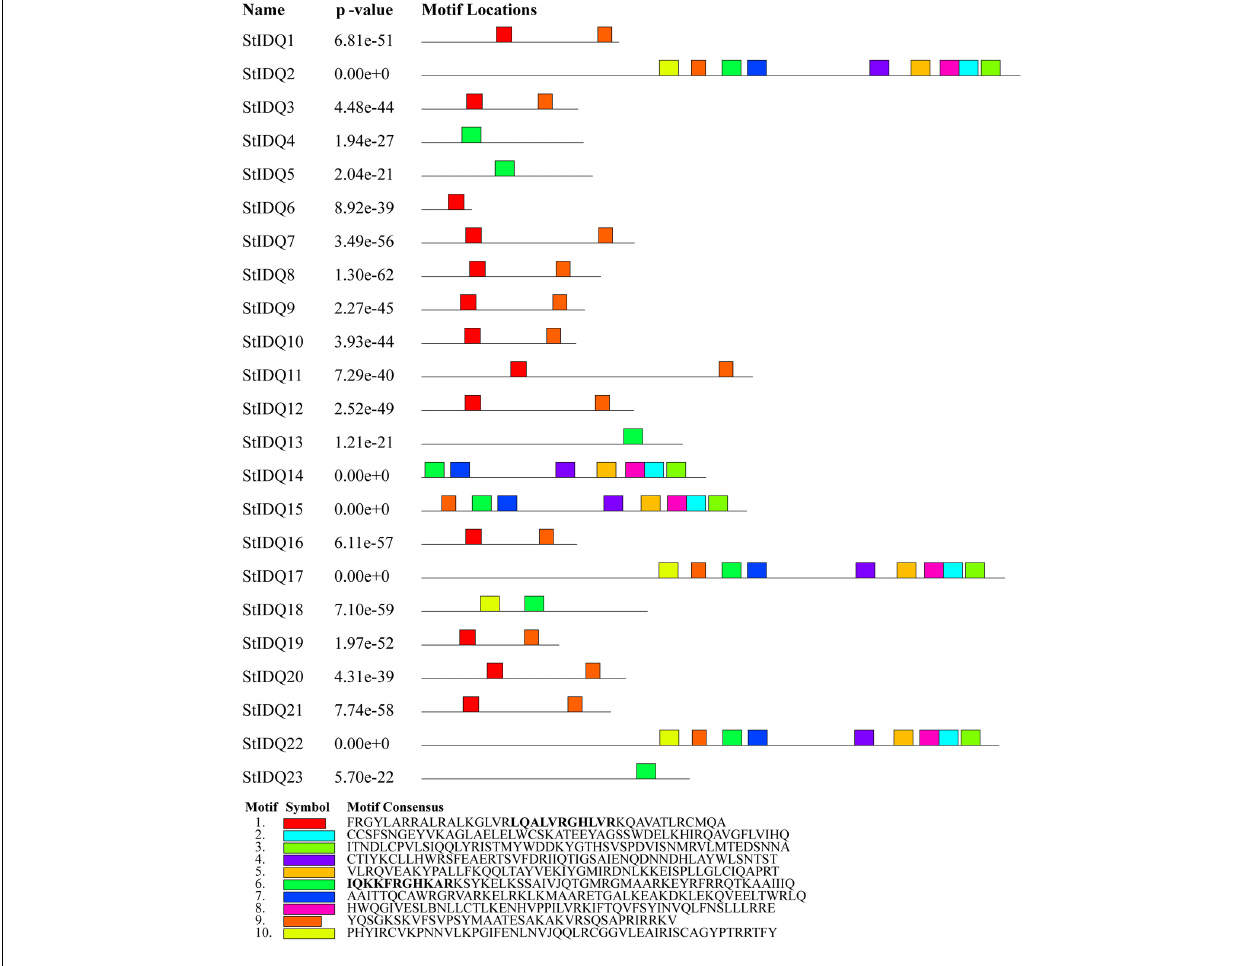
Frontiers in Genetics |